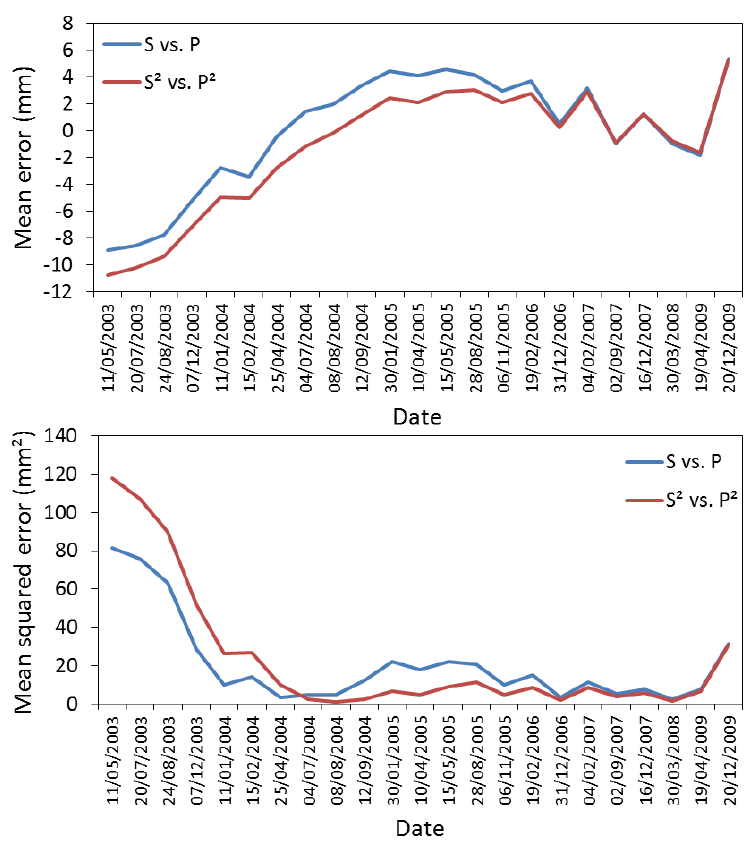
Figure 7. Mean values of the mean error and mean squared error for the five considered piezometers, obtained for the two best linear regression models (S = a × P + b; S² = a × P² + b). The granulometry of subsurface sediments has a significant impact on the ground subsidence.